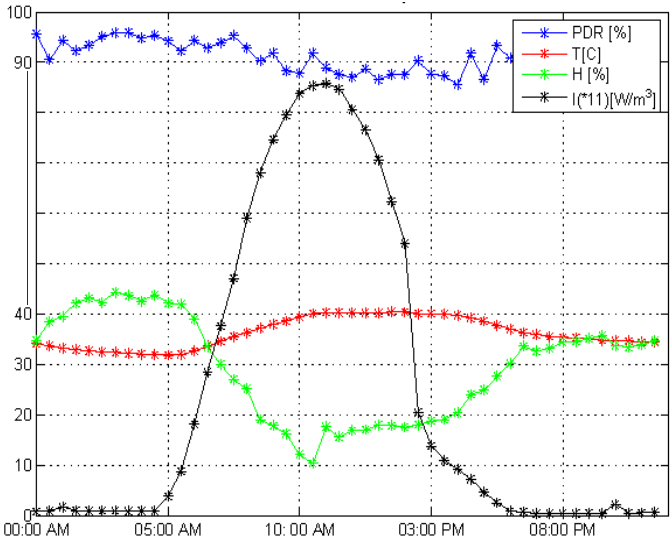
Figure 5. Behavior of FSO link vs weather factors during May 2015 (pre-summer season).